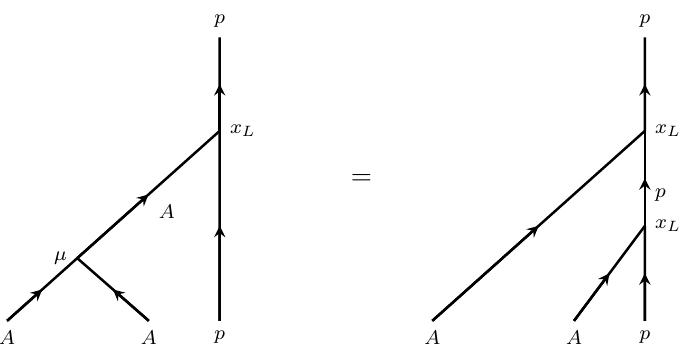
Figure 15 . Associativity axiom for a left A -module ( p; x L ).